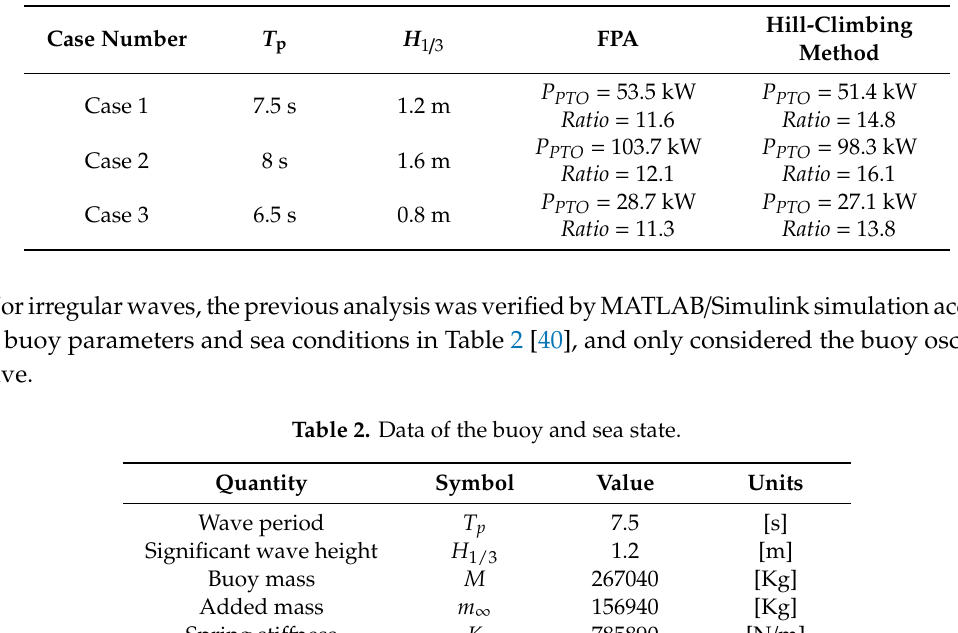
Table 1. Comparison of average power absorption and peak-to-average ratio in simulation.